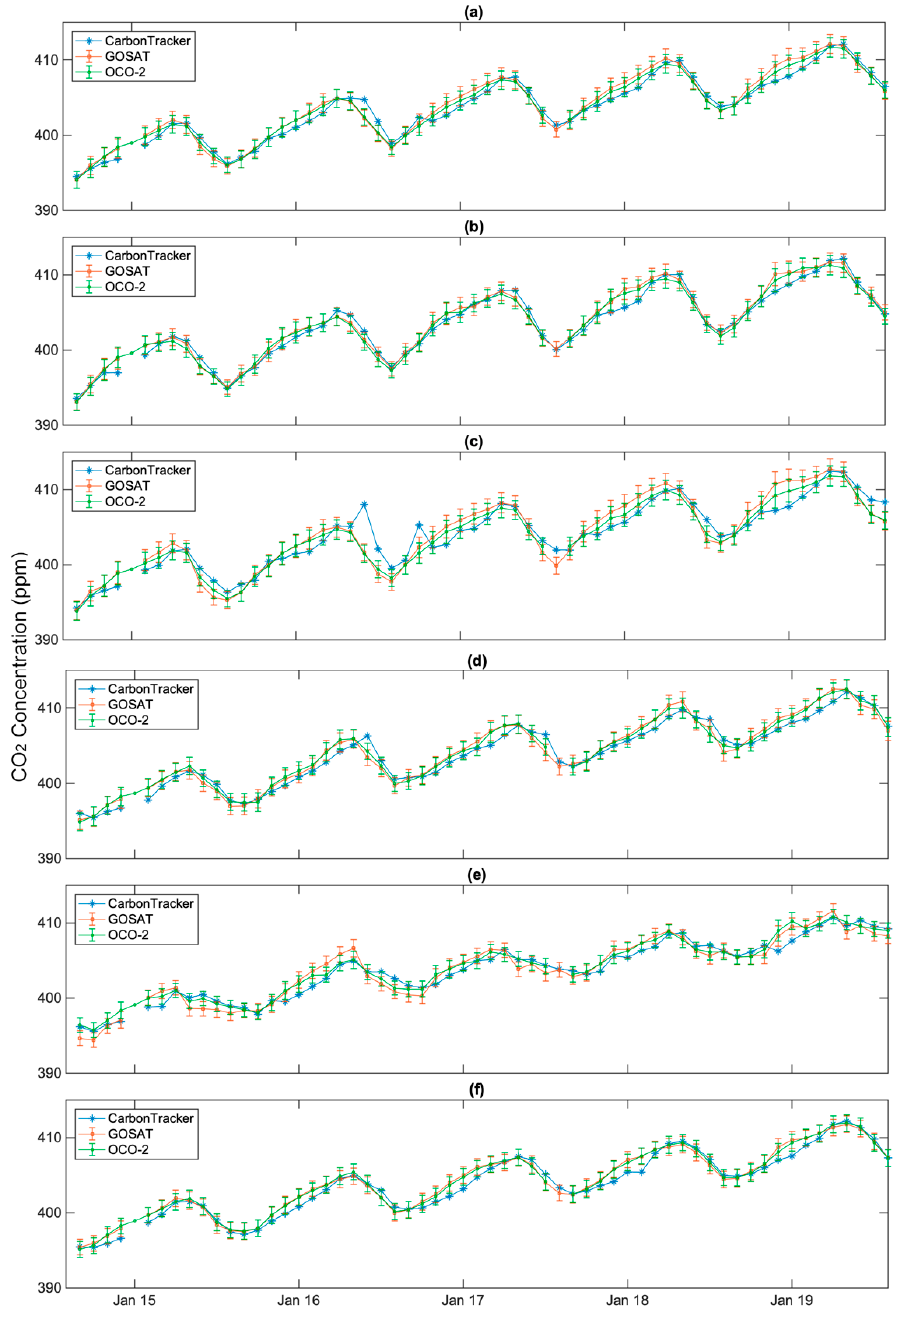
Figure 6. The time-series variations of monthly averaged XCO 2 derived from CT and the two satellite datasets for a period of 5 years ranging from September 2014 to August 2019 over ( a ) Asia; ( b ) Central Asia; ( c ) East Asia; ( d ) South Asia; ( e ) Southeast Asia; ( f ) and Western Asia, The gaps in the graph show the missing data.